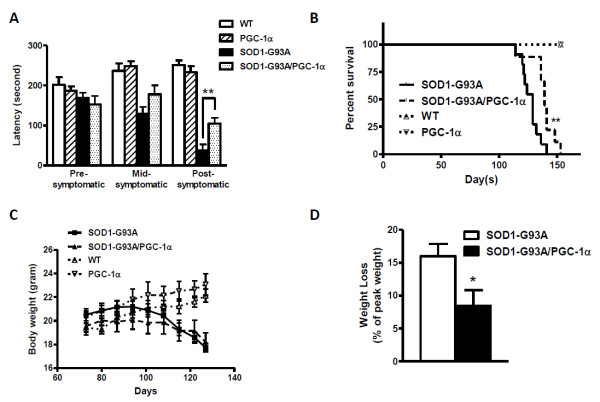
PGC-1α improved motor performance and survival in SOD1 mutant mice. (A) Motor performance as measured by rotarod test in WT, PGC-1α, SOD1-G93A and SOD1-G93A/PGC-1α animals (**p < 0.01); (B) Survival analysis of WT, PGC-1α, SOD1-G93A and SOD1-G93A/PGC-1α animals (**p < 0.01 by Mantel-Cox test); (C) Average body weight of WT, PGC-1α, SOD1-G93A and SOD1-G93A/PGC-1α animals; (D) Average weight loss (percentage of peak weight) of SOD1-G93A and SOD1-G93A/PGC-1α animals (*p < 0.05).